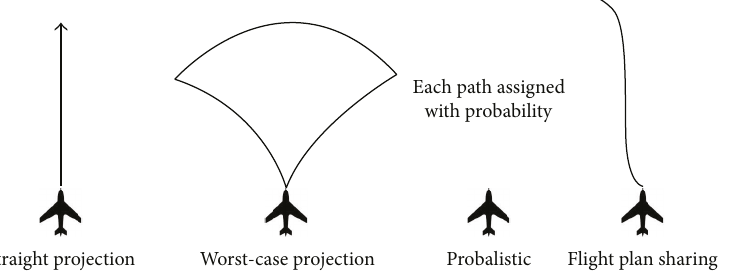
Figure 1: Schematics of path prediction models.